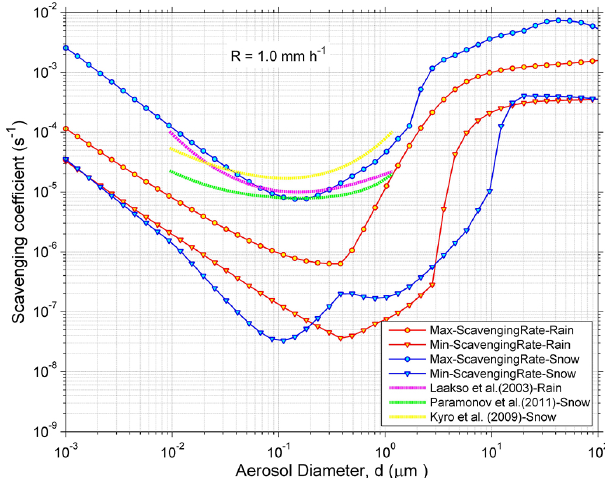
Fig. 10. The range of 3 snow generated from a combination of all four panels in Fig. 8 and the range of 3 rain from a review in Wang et al. (2010). Both pairs of curves represent the uncertainties in ex- isting theoretical formulations. Also shown are curves for two em- pirical 3 snow parameterizations and one empirical 3 rain parameter-